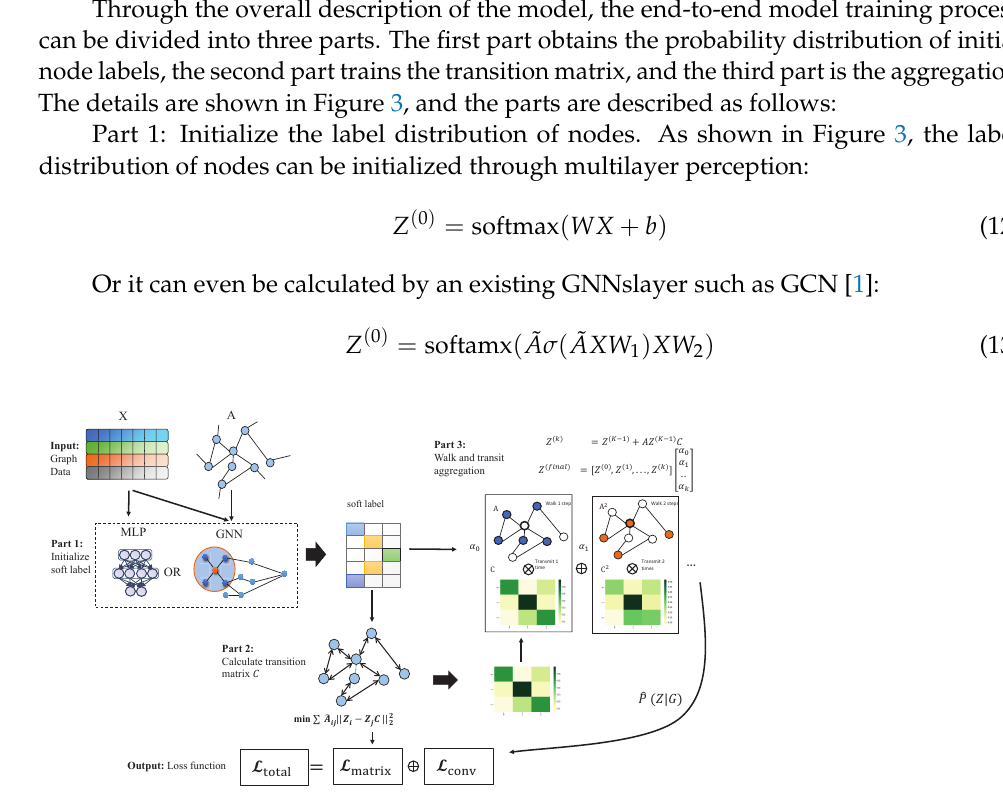
Figure 3. Overall training process of the WTGNN. Input the graph node feature and adjacency matrix. The WTGNN first takes the existing GNN or MLP to obtain the soft label of each node, then uses the soft label to train the transition matrix C through the auxiliary task of first-order neighbor prediction, and finally, each node aggregates the predicted value of each k-hop neighborhood to obtain P ( Z | G ) and calculates the